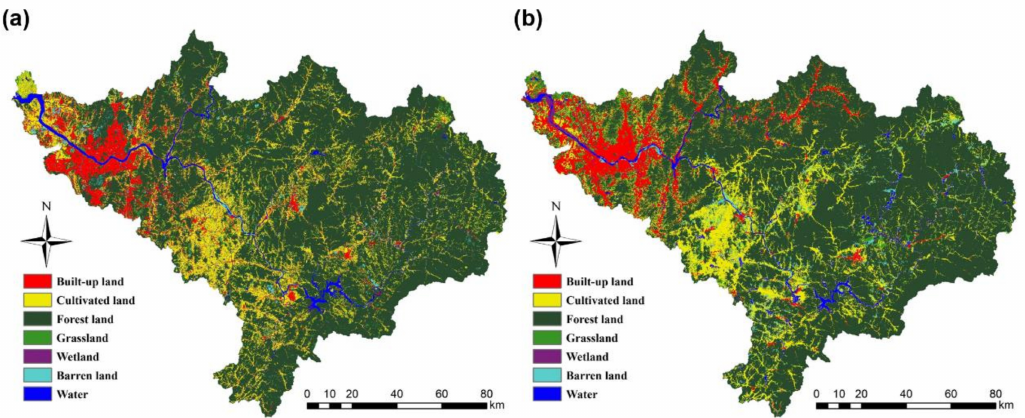
Figure 4. ( a ) Actual and ( b ) simulated land use map in